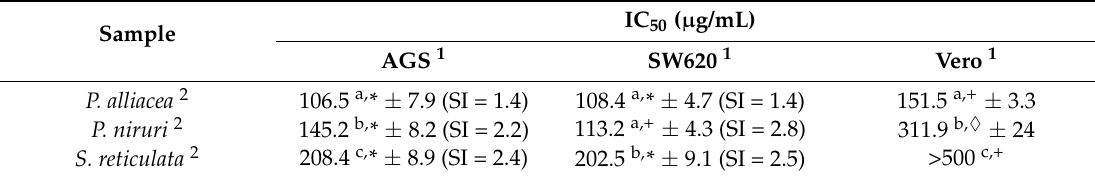
Table 4. Cytotoxicity of extracts to gastric (AGS) and colon (SW620) adenocarcinoma cells as well as to control Vero